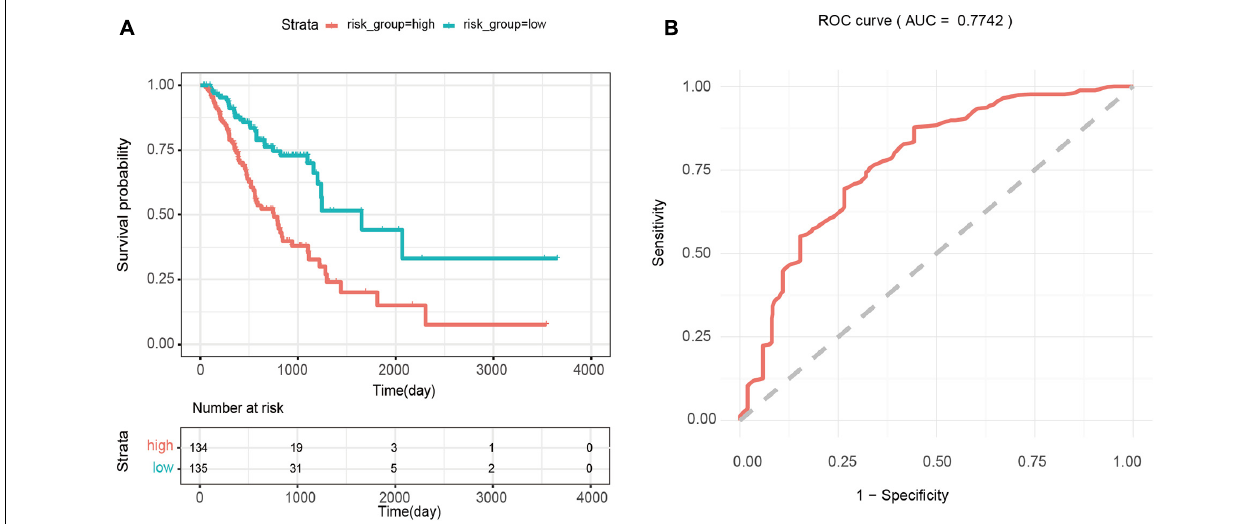
FIGURE 5 | Survival analysis based on four prognostic PmBs. (A) Kaplan–Meier curves analysis for overall survival of patients between the high- and low-risk groups; the upper panel represents the Kaplan-Meier curve for the high and low risk groups, the lower panel shows the cumulative number of deaths. (B) ROC analysis for prognostic risk model with the 4